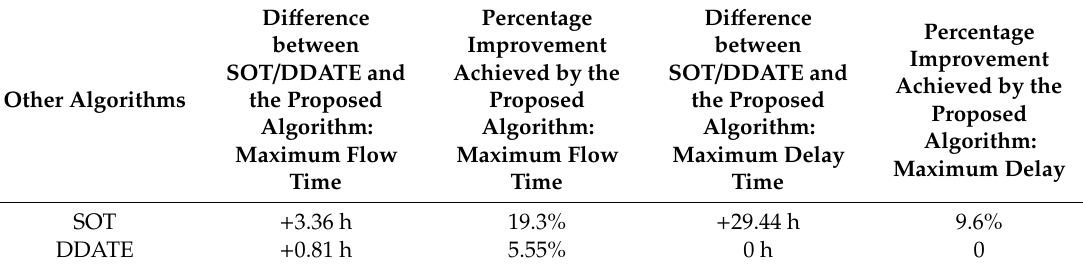
Table 10. Di ff erence between the proposed scheduling algorithm and two existing algorithms.